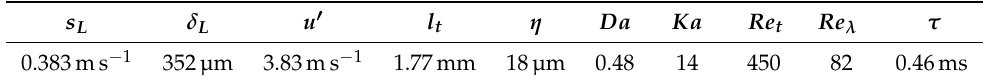
Table 1. HIT initial